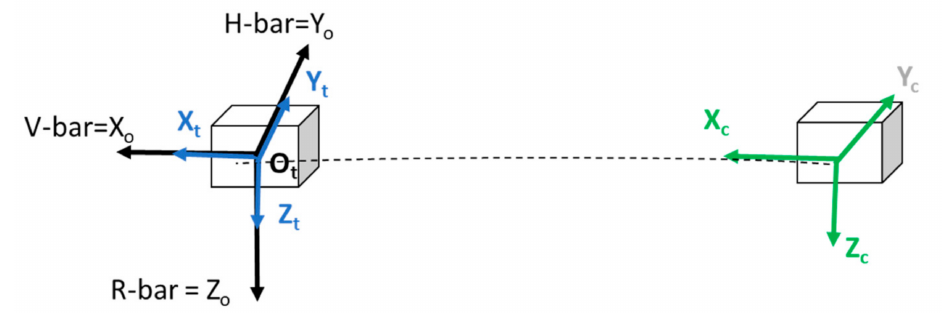
Figure 1. Schematic of the reference